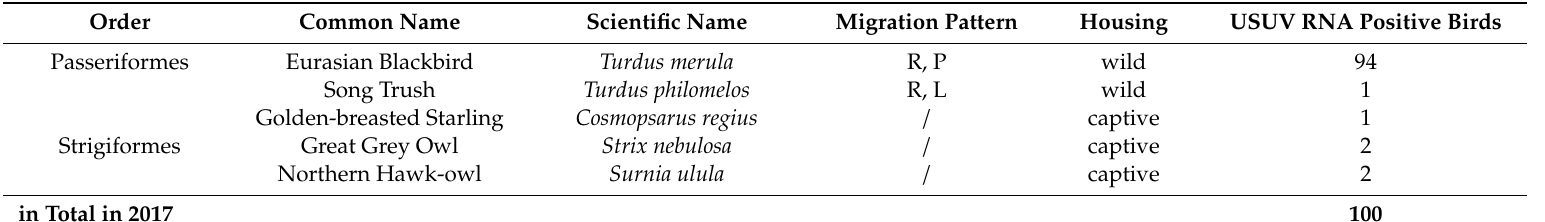
Table 3. Dead birds of the second sample panel tested positive for Usutu virus (USUV) infection by qRT-PCR in